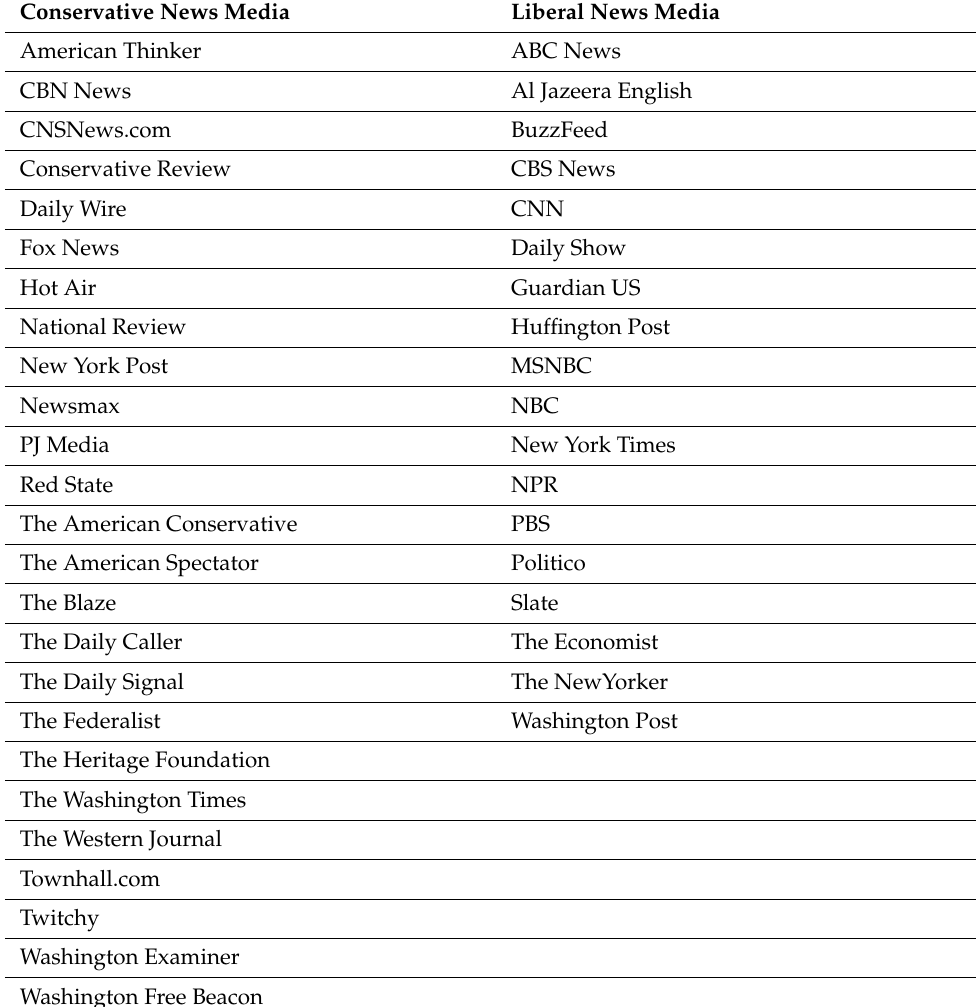
Table 1. List of conservative and liberal news media included in the study